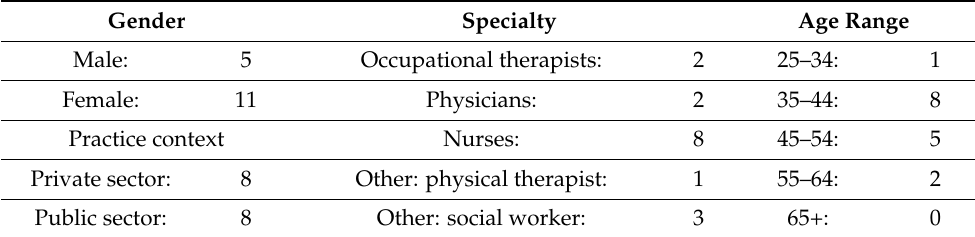
Table 9. Characteristics of healthcare professionals.